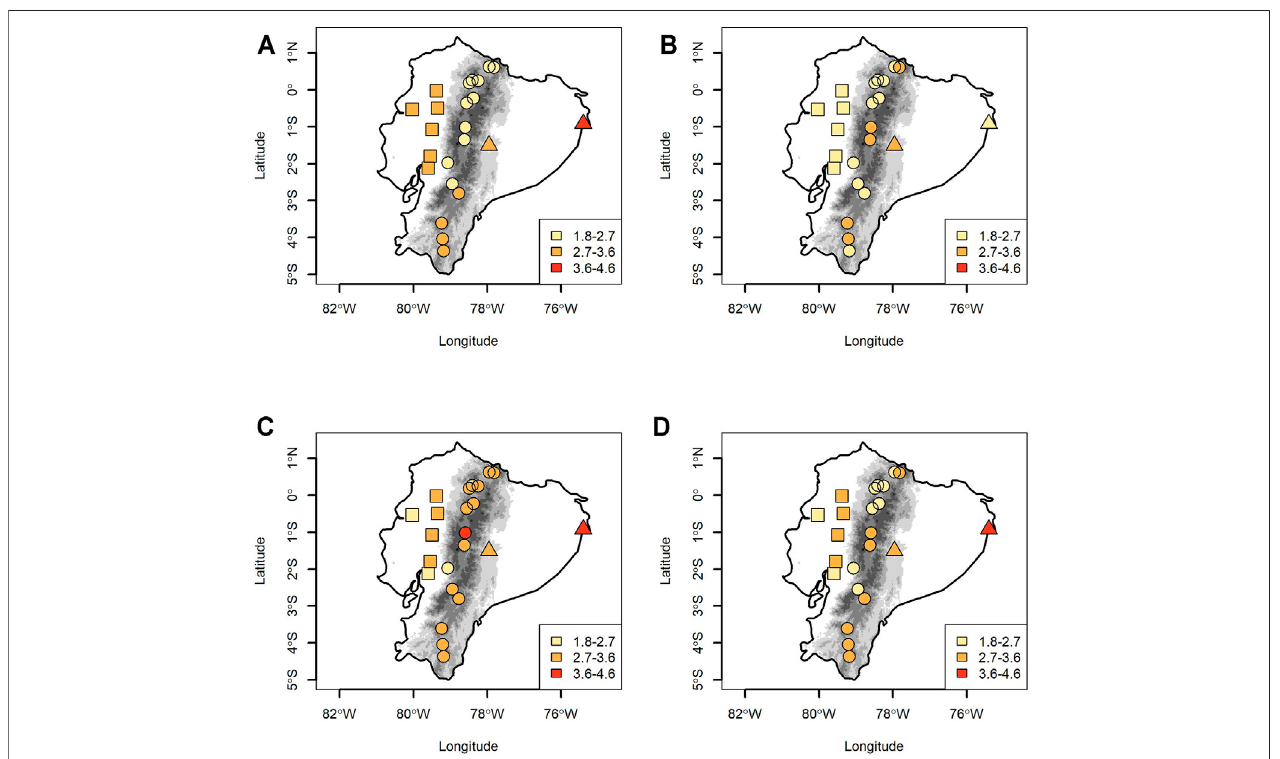
FIGURE 4 | HRW mean value for the period 2041 – 2070 from CSIRO (A) , GISS (B) , and IPSL (C) . Figure 4D is the ensemble that explains the median from three WGCMs.